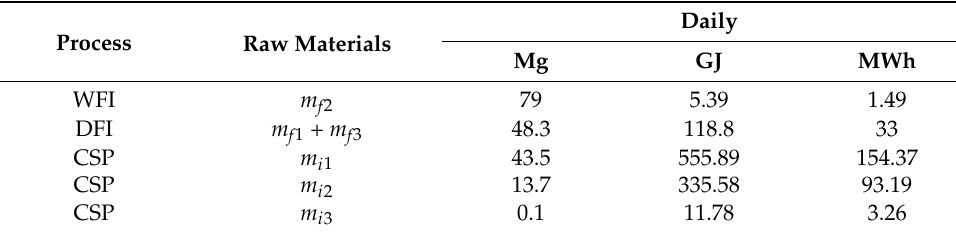
Table 7. Mass and energy production using ERWP